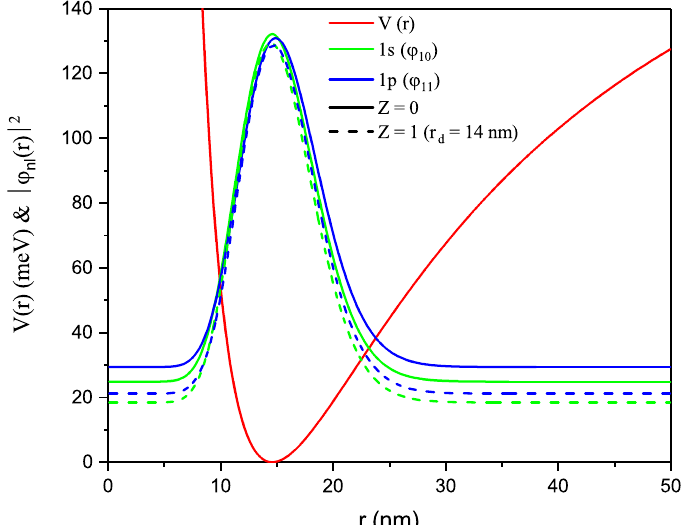
Figure 1. The confining SMKP (V(r)) and probability density | φ nl ( r ) | 2 as a function of r